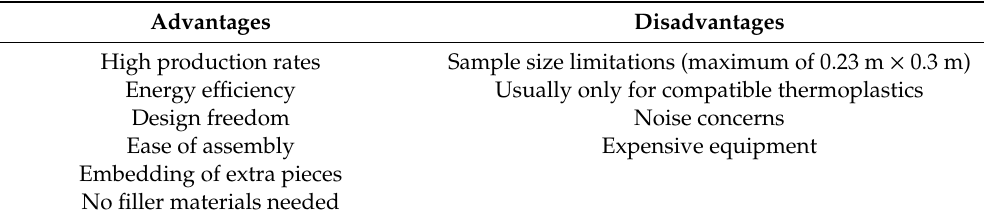
Table 3. Advantages and disadvantages of USW.